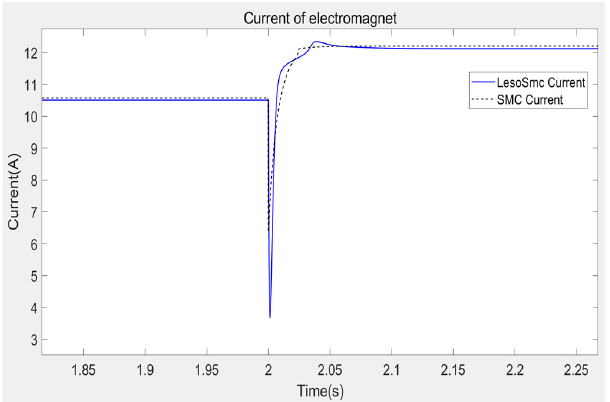
Figure 17. Partial enlarged view of current under SMC and LESOSMC.